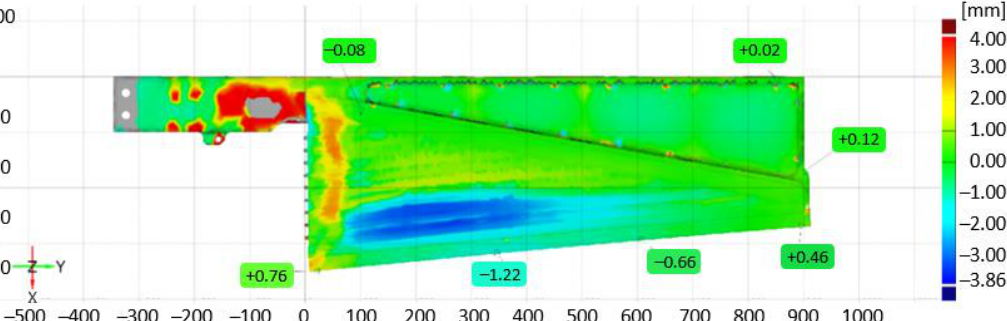
Figure 10. Difference of outer geometry between simulation and experiment for 30% chord morph- ing. Positive values stand for measured surfaces higher than the simulation; negative values indicate a measurement that is below the expectation of the simulation.